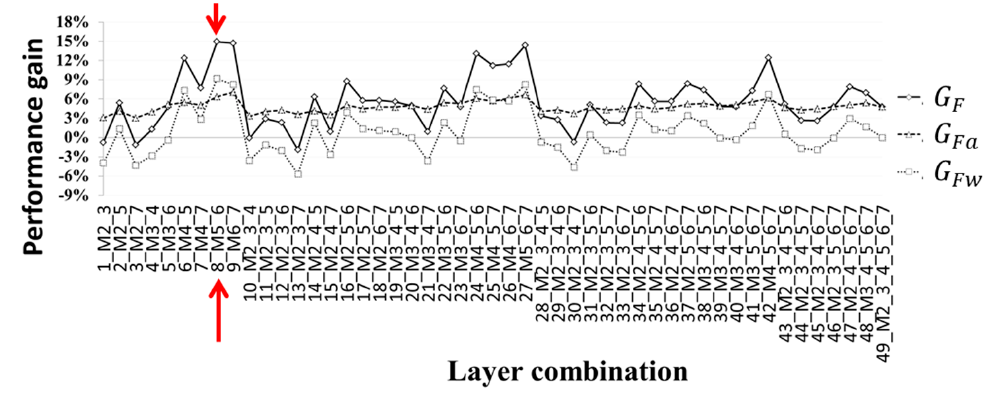
Figure 3. AG performance gain results estimated by the analytical method.